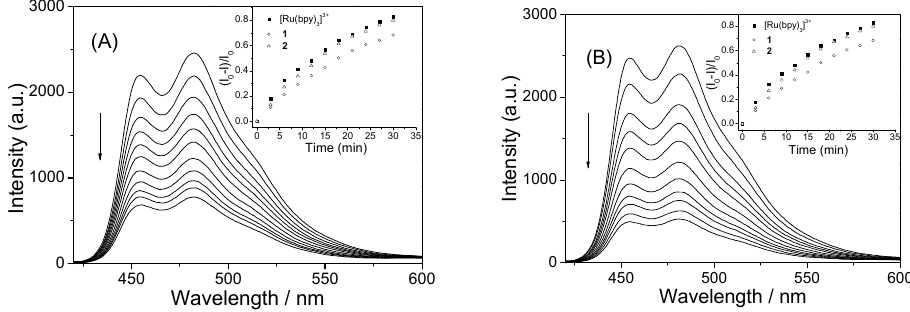
Figure 9. The change on the fluorescence of Ru(II)-DPBF system ( 1 ( A ) and 2 ( B )).